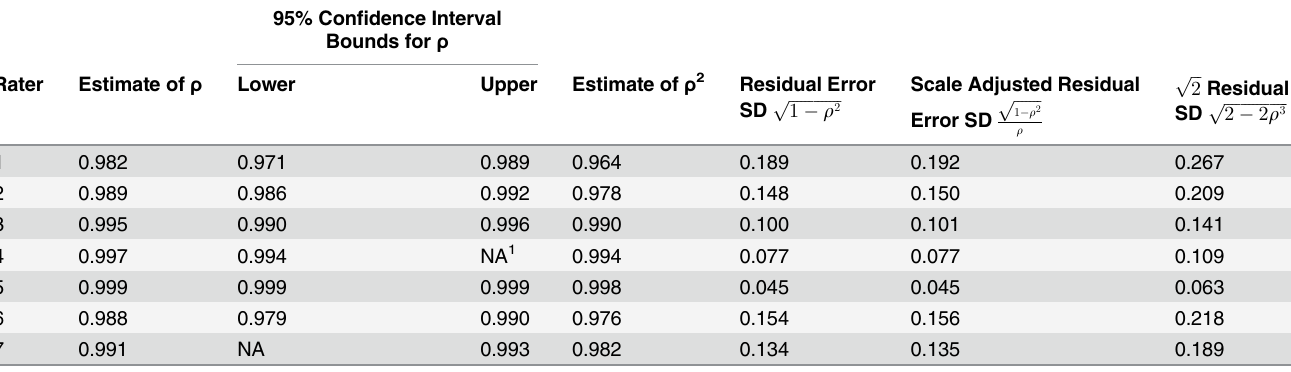
Table 3. Factor loading estimates ρ for the one factor ordinal model with seven raters.